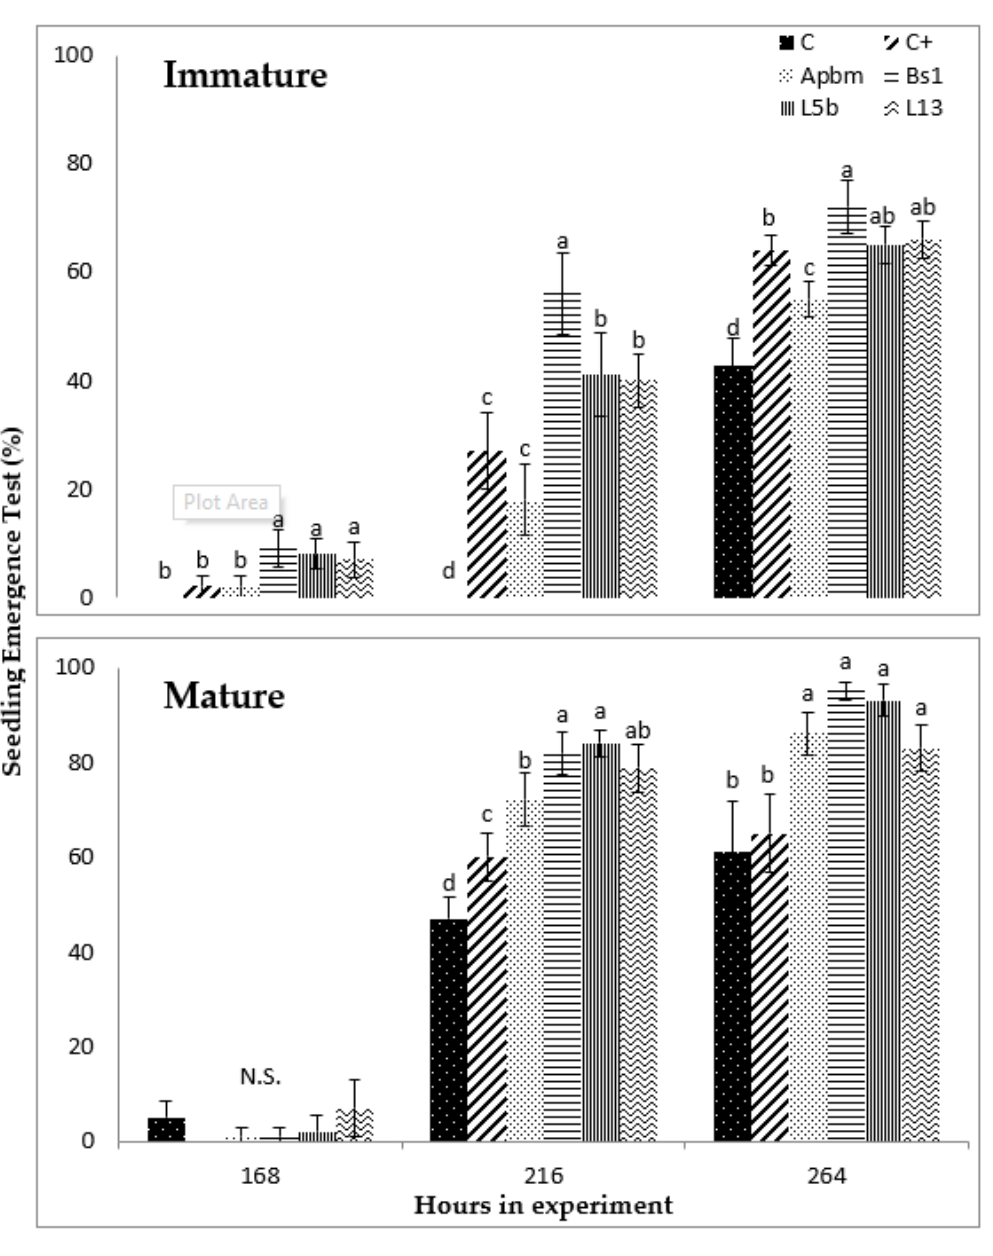
Figure 6. Cumulative seedling emergence percentages ± SE of immature and mature pepper seeds during the emergence test. Means with different letters in the same hour indicate significant differences at the 5% level. N.S.: not significant.